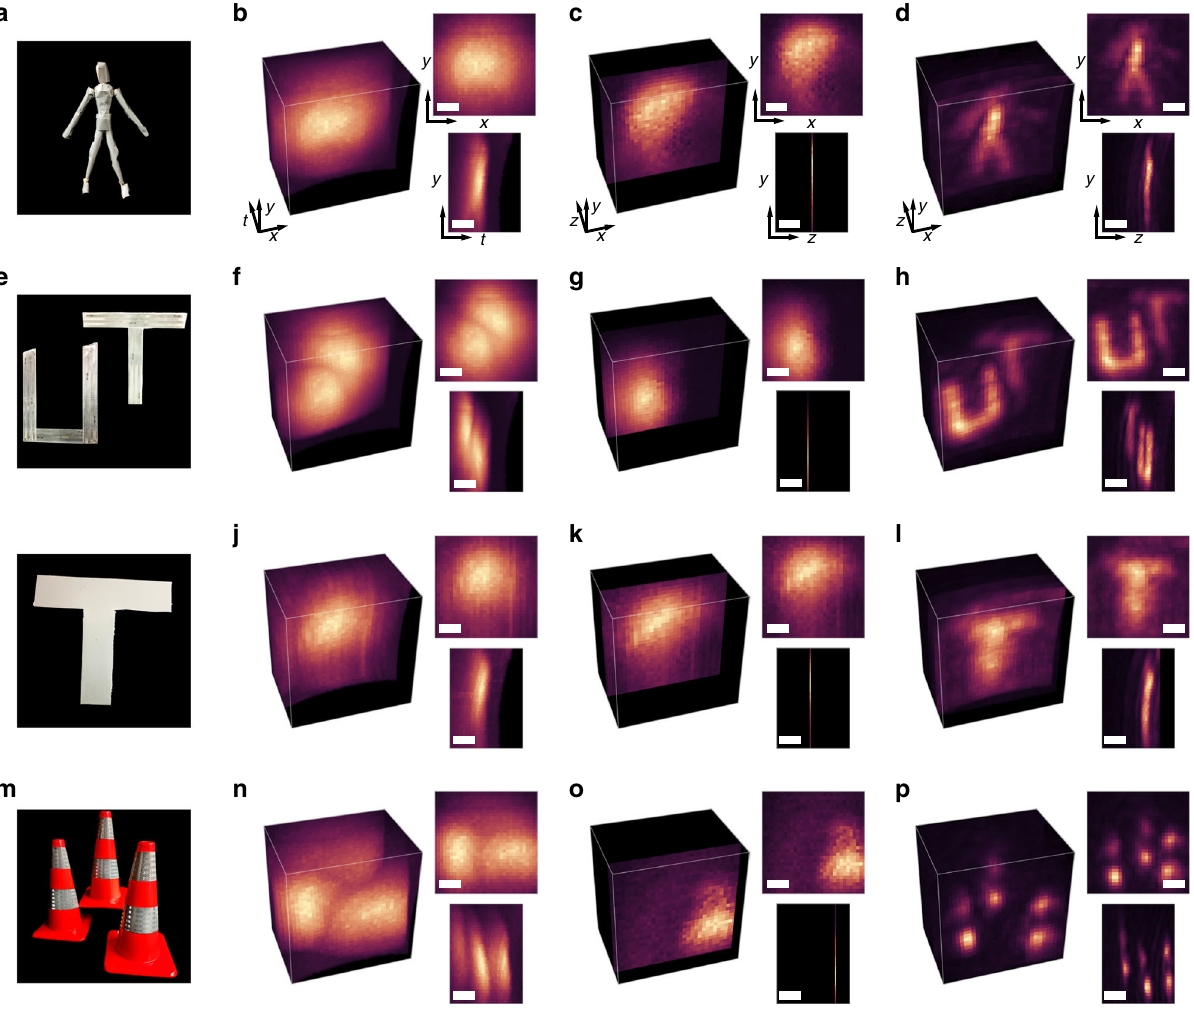
Fig. 3 Confocal diffuse tomography reconstructions from SPAD measurements. A photograph of the hidden retrore fl ective mannequin ( a ) and maximum intensity projections of the captured time-resolved measurements ( b ), a time-gated measurement slice ( c ), and the CDT reconstruction ( d ) are shown. A photograph, measurements, and reconstructions are also shown for two letter-shaped retrore fl ective hidden objects at different distances ( e – h ), a diffuse hidden object ( i – l ), and a group of traf fi c cones ( m – p ). We apply a depth-dependent scaling to the traf fi c cone visualization to account for radiometric falloff. Scalebars indicate 15 cm or 1 ns, and a gamma of 1/3 is applied to each maximum intensity projection 51 . Captured data are included in Supplementary Data 1 and additional visualizations are provided in Supplementary Movie